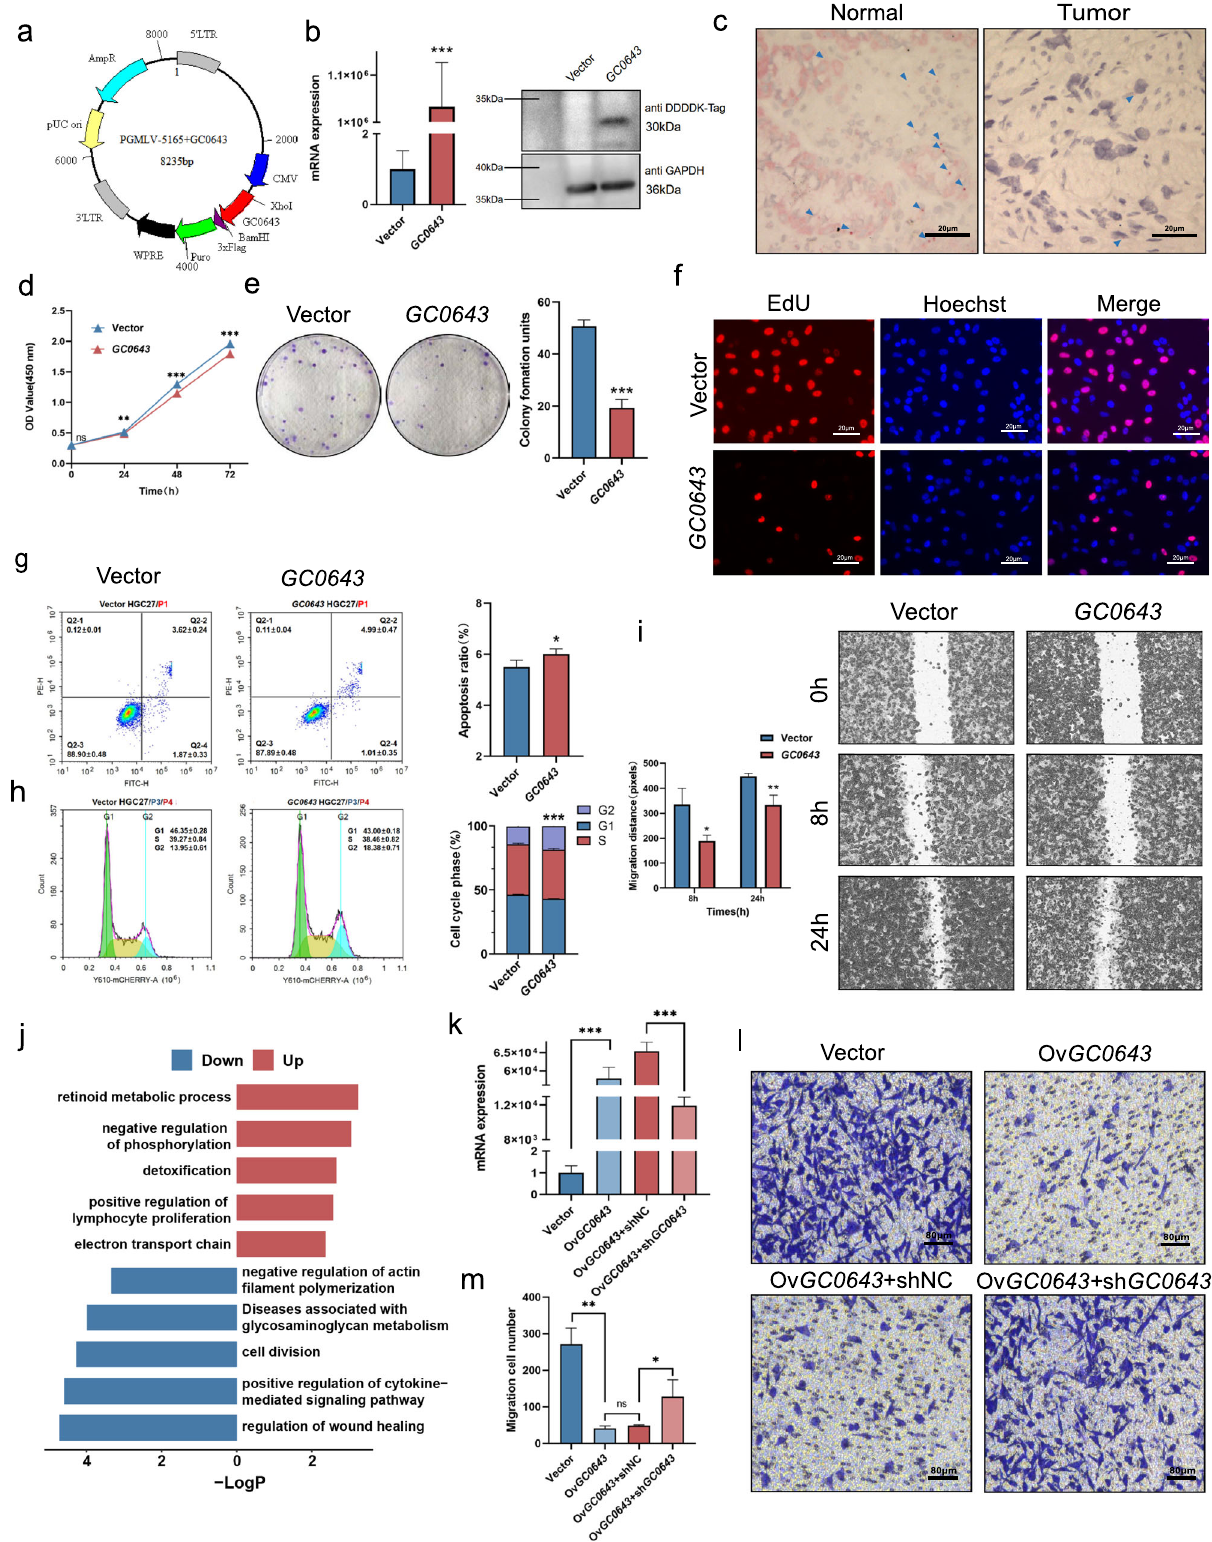
Identi fi cation of distributed genes related to gastric cancer Theabsencefrequenciesofdistributedgenesingastriccancerdatasetsand SGDP data were compared. The signi fi cance of the difference of fre- quenciesforeachgeneabsenceintwogroupswascalculatedusingFisher ’ s exact test. The P values were further corrected by FDR. Fisher ’ s exact test is used to calculate the correlations between gene PAVs with clinical